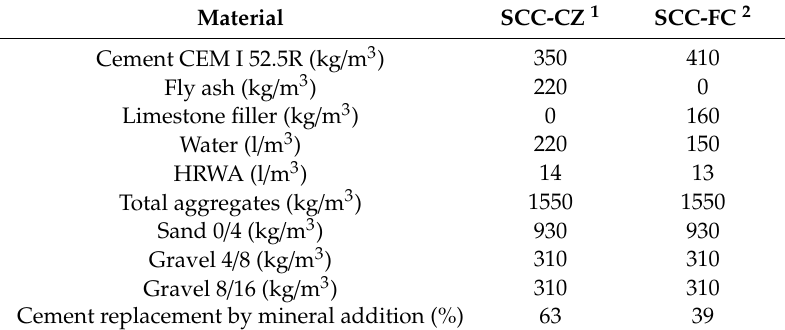
Table 1. Mix proportions of self-consolidating concrete compositions.